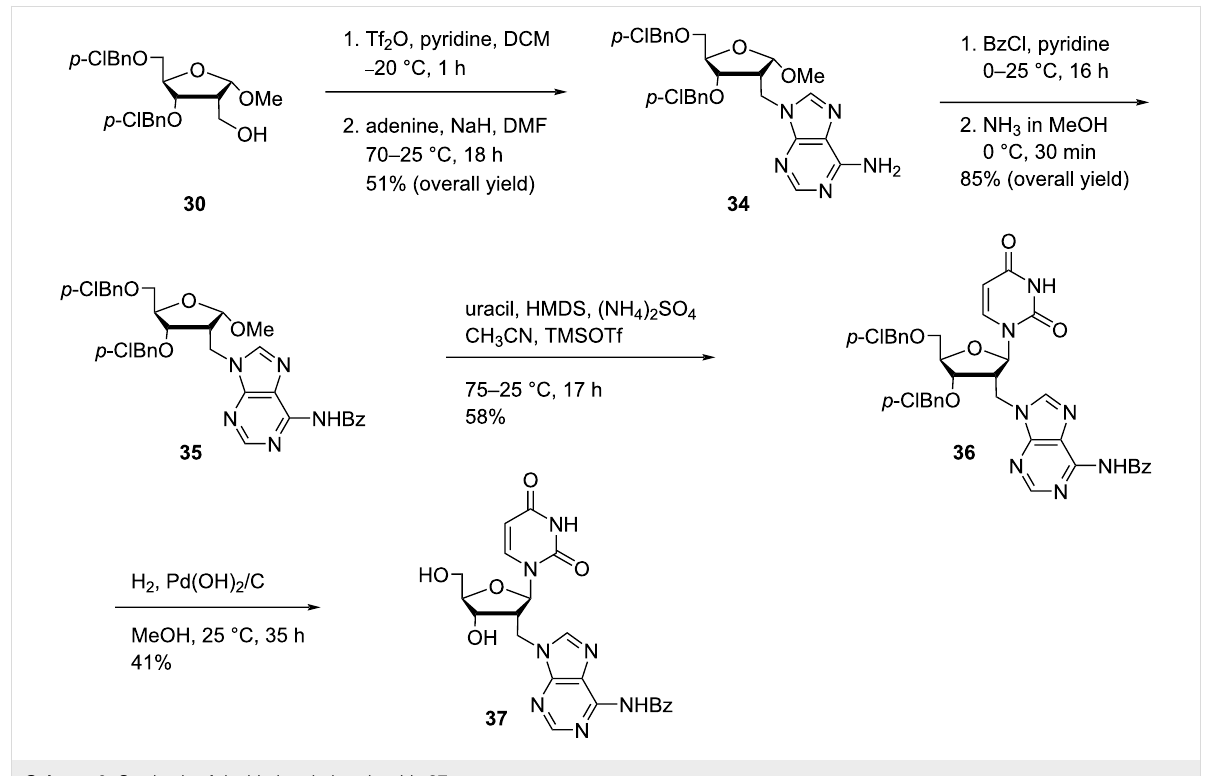
Scheme 9: Synthesis of double-headed nucleoside 37